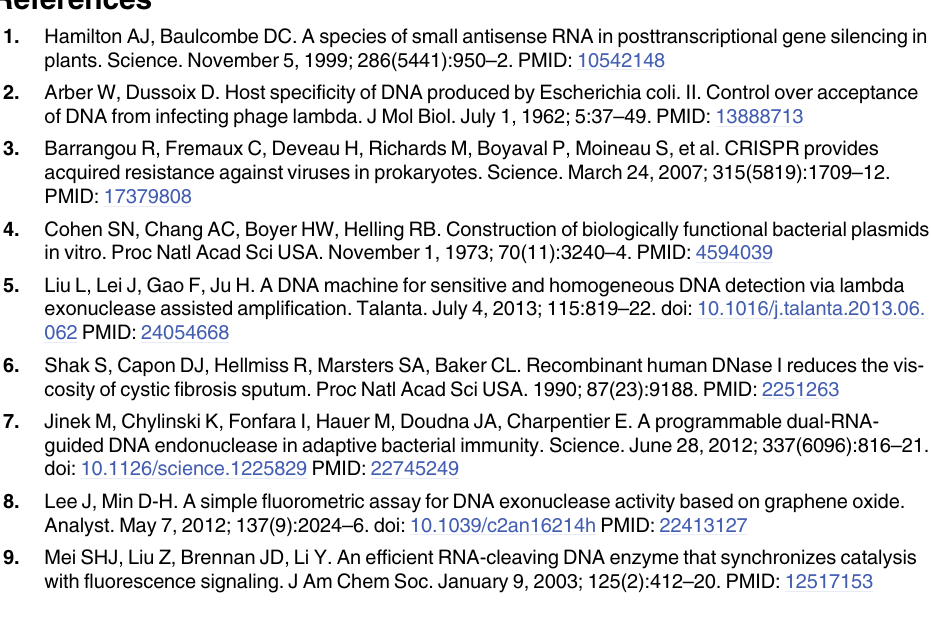
measured every 1.3 s and 0.3 u/ μ l T4PNK (red) or water (blue) was added after 120 s. Straight line curve fitting of the first 10% of the reaction is represented by the green line. Reaction veloc- ity was calculated to 0.56 nM s -1 . (TIF) S5 Fig. Standard curve for ExoIII reactions. 1 μ M MDCC-PBP and varying concentrations of PO in 66mM Tris-HCl (pH 8.0) and 0.66mM MgCl was incubated at 37°C for 20 min. KH 2 4 2 is plotted against relative fluorescence units (RFU). Straight line curve The concentration of P i fitting gives a slope equal to 899.2 ± 59.54 RFU nM -1 . The R 2 -value of the curve straight line fit- ting was 0.98. (TIF) S6 Fig. Standard curve for DzSJ reactions. 1 μ M MDCC-PBP and varying concentrations of PO in 40 mM Tris-HCl (pH 7.5), 20 mM MgCl2 and 50 mM NaCl was incubated at KH 2 4 room temperature for 15 min. The concentration of P is plotted against relative fluorescence i units (RFU). Straight line curve fitting gives a slope equal to 869.1 ± 40.32 RFU nM -1 . The R 2 - value of the curve straight line fitting was 0.99.